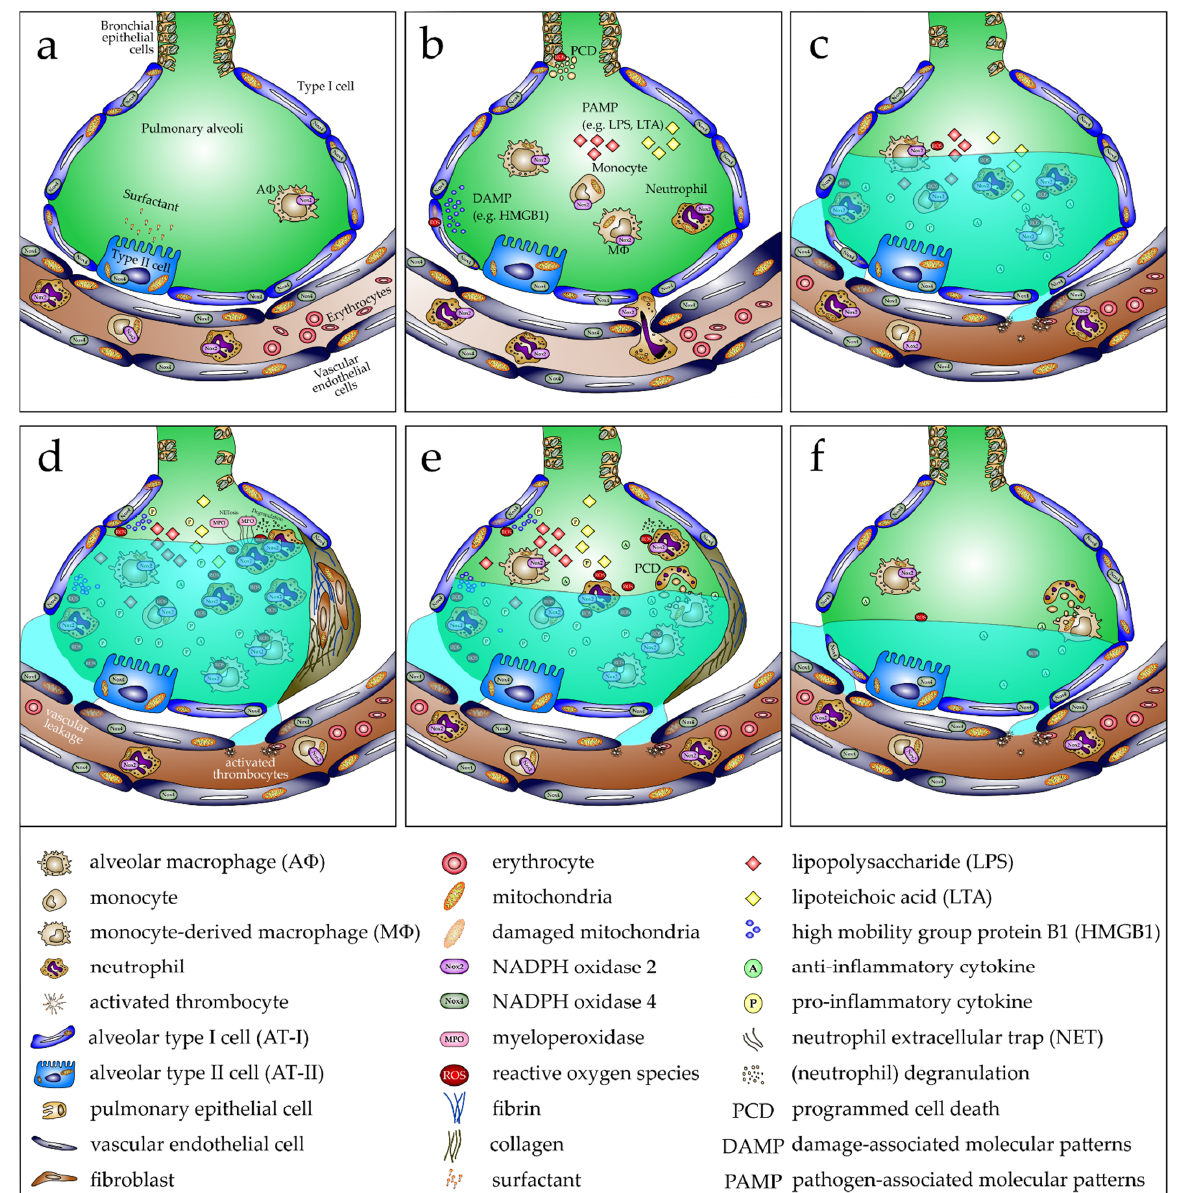
Figure 3. Development, progression, and resolution of ARDS in response to pathogen-associated molecular patterns (PAMPs). ( a ) In the healthy lung, alveoli show no neutrophil infiltration and only limited alveolar macrophages (A Φ ). Alveolar type II cells (AT-II) produce adequate surfactant to keep the alveolar epithelium covered effectively, thus reducing the surface tension, necessary to prevent a collapse of the alveoli after expiration. Consequently, optimal gas exchange occurs. ( b ) Following inhalation of bacteria or bacterial components such as lipopolysaccharide (LPS) or lipoteichoic acid (LTA), which are PAMPs, bronchial and alveolar epithelial cells are activated, increasing expression of proinflammatory chemokines and cytokines. This provokes infiltration of immune cells, mainly neutrophils and some monocytes, from the bloodstream. Consequently, the proinflammatory response is enhanced, including proinflammatory cytokines and mediators such as reactive oxygen species (ROS), produced primarily by the phagocytic NADPH oxidase (Nox2) expressed by neutrophils and monocytes/M Φ . Programmed cell death (PCD) of bronchial epithelial cells is induced and HMGB1 as a damage-associated molecular pattern (DAMP) from alveolar type I cells (AT-I) is released, which is also associated with cell demise. ( c ) Cell death is linked to the damage of the alveolar–capillary barrier, causing lung edema, which significantly reduces lung function